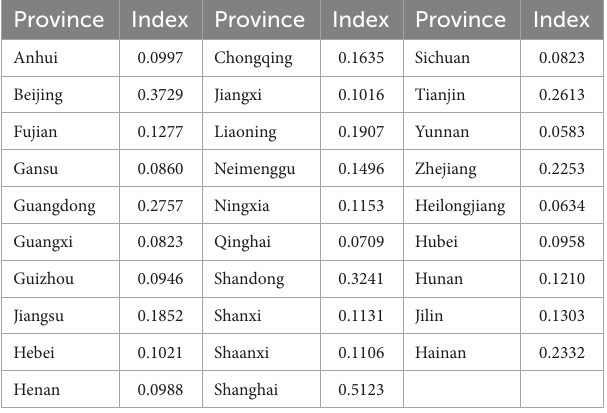
TABLE 2 2019 Business environment evaluation results by province in